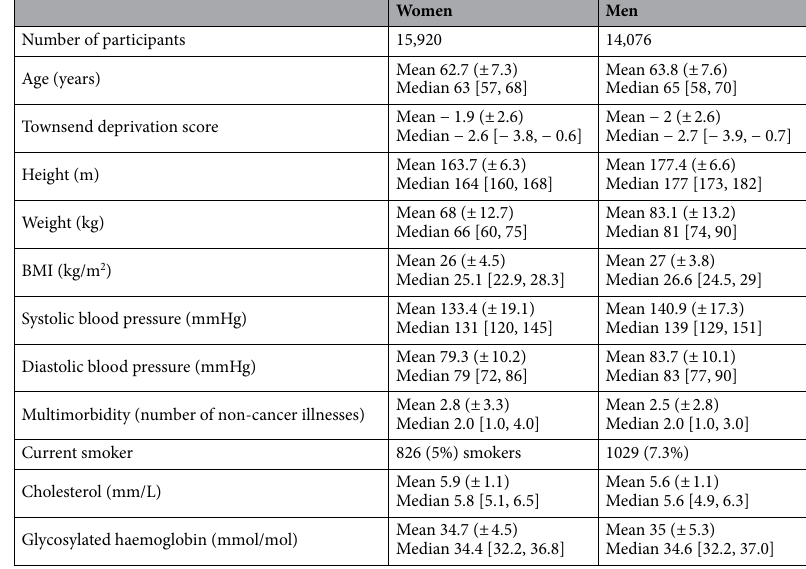
Table 1. Baseline participant characteristics. Categorical variables are as number (percentage). Continuous variables are reported as mean (± standard deviation) and median [25th percentile, 75th percentile]. All measures are as recorded at the imaging visit, except for serum cholesterol and glycosylated haemoglobin, which are from baseline.